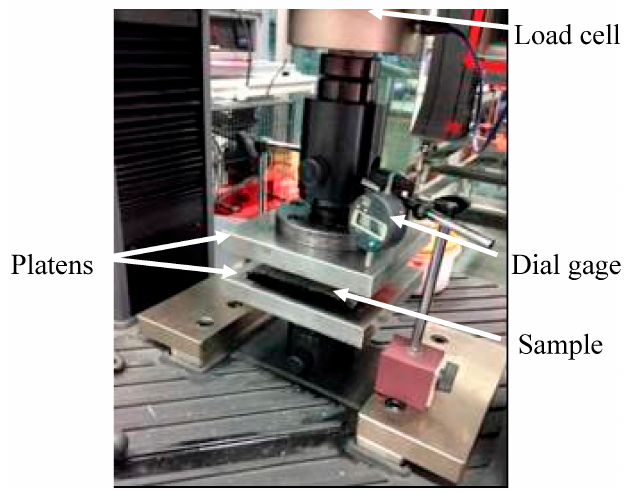
Figure 2. Picture of the compaction test setup.